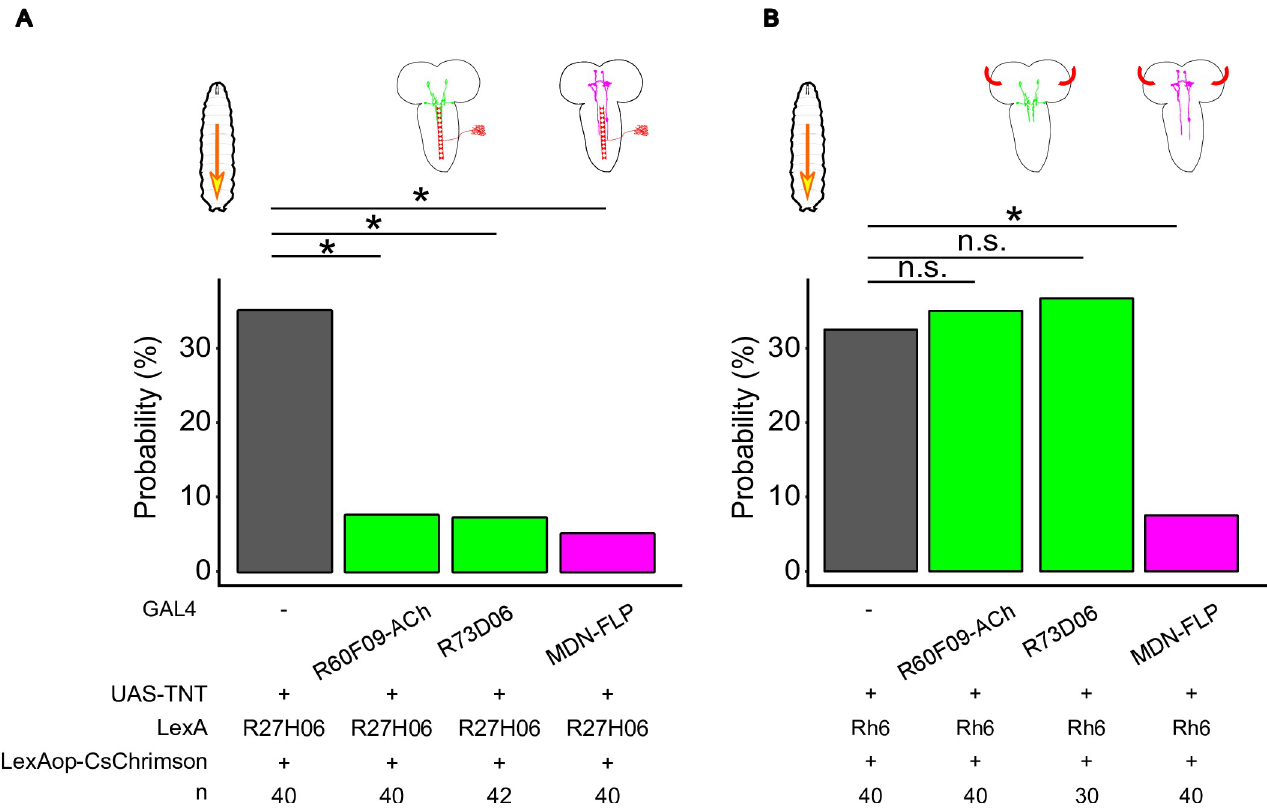
Fig 10. C4da neurons require AMBs and MDNs to evoke backward locomotion. The probability of animals exhibiting backward waves during optogenetic activation of C4da neurons (A) or BO (B) for 30 seconds. Genotypes shown in SI Table. We evaluated statistical significance by Fisher’s exact test with the Holm method. �� p < 0.01, � p <